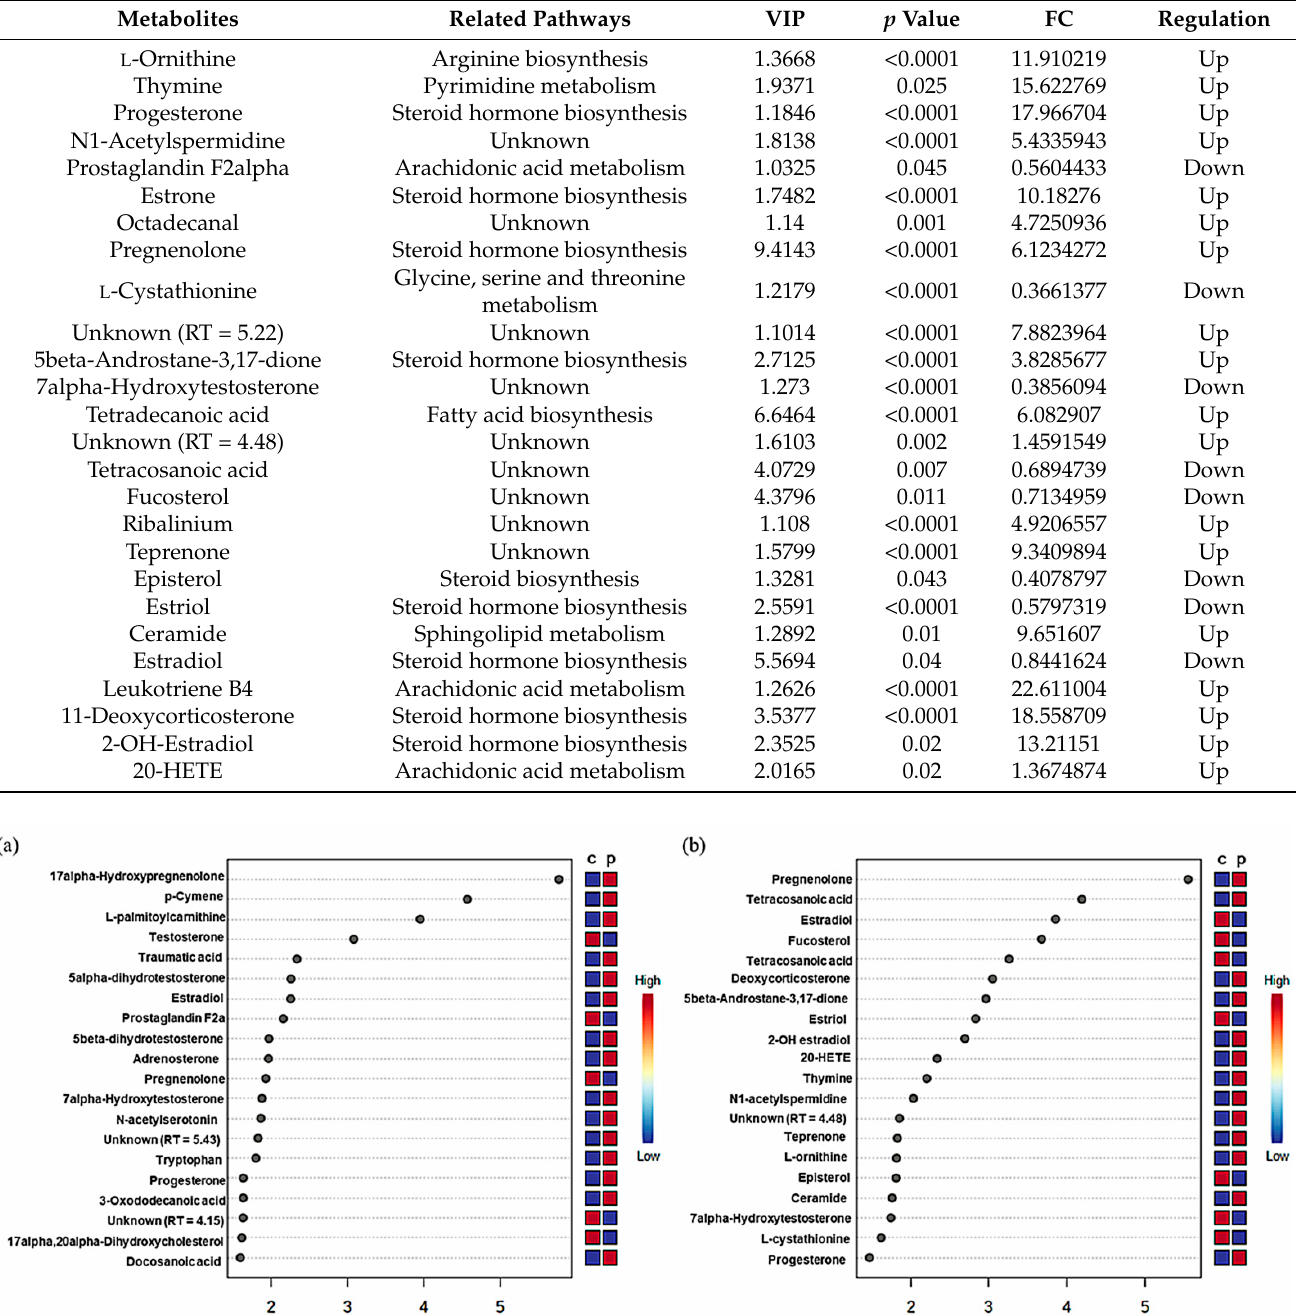
Table 2. Differentially regulated metabolites in patients with pattern baldness and normal controls in female groups.